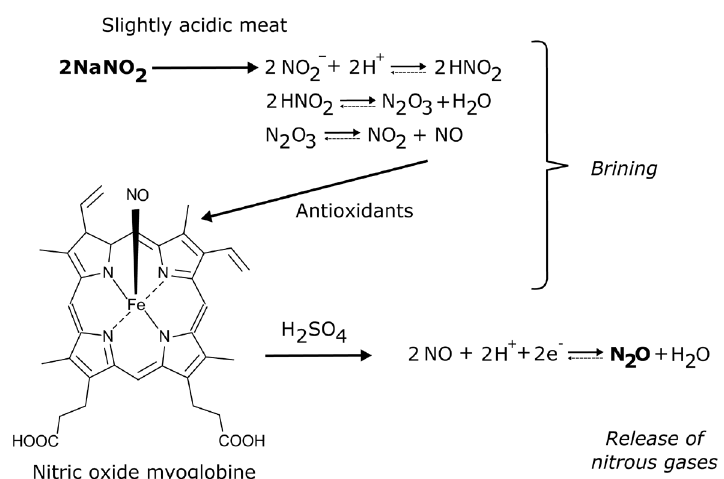
Figure 1. Postulated reaction schemes: brining with NO2 - , formation of N experiment with labelled Na 15 NO